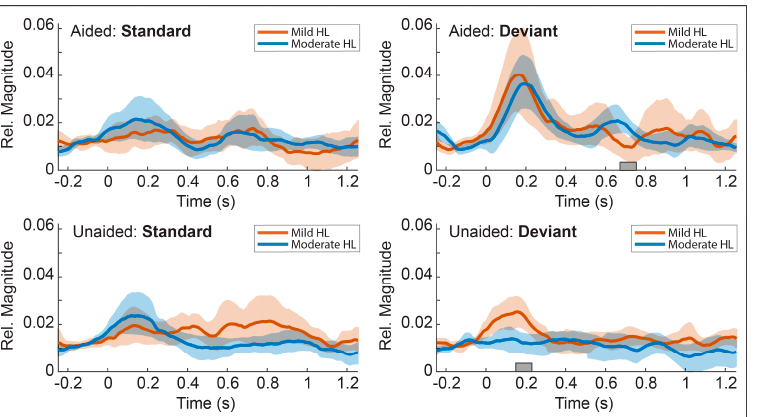
Figure 8. Mean temporal envelopes of alpha band coherence: post-hoc comparisons. Mean tem- poral envelopes for the alpha band coherences showing comparisons of infants with Mild hearing loss versus Moderate hearing loss collapsed across contrast type. Responses for the aided condition are shown along the top row and responses for the unaided condition are shown along the bottom row. Standard responses are shown in the left column and deviant responses in the right column. Shaded bars along the abscissa represent time regions with significant differences between the Mild and Moderate hearing loss groups (gray = p <